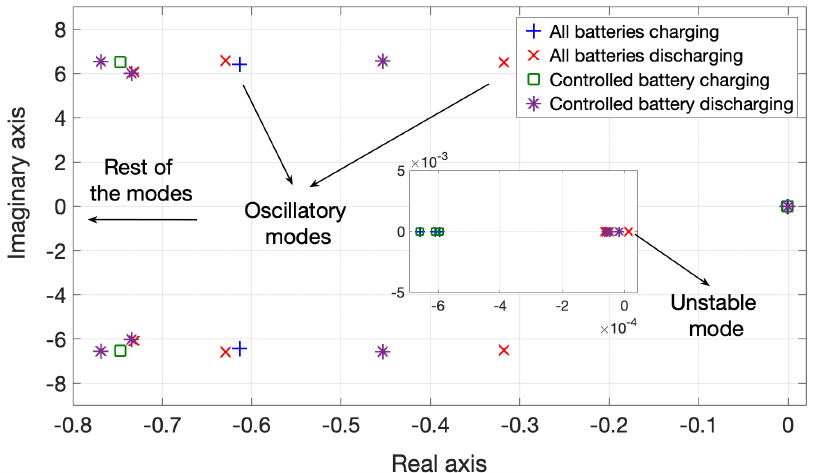
Figure 2. Eigenvalues of the system in the presence of batteries.